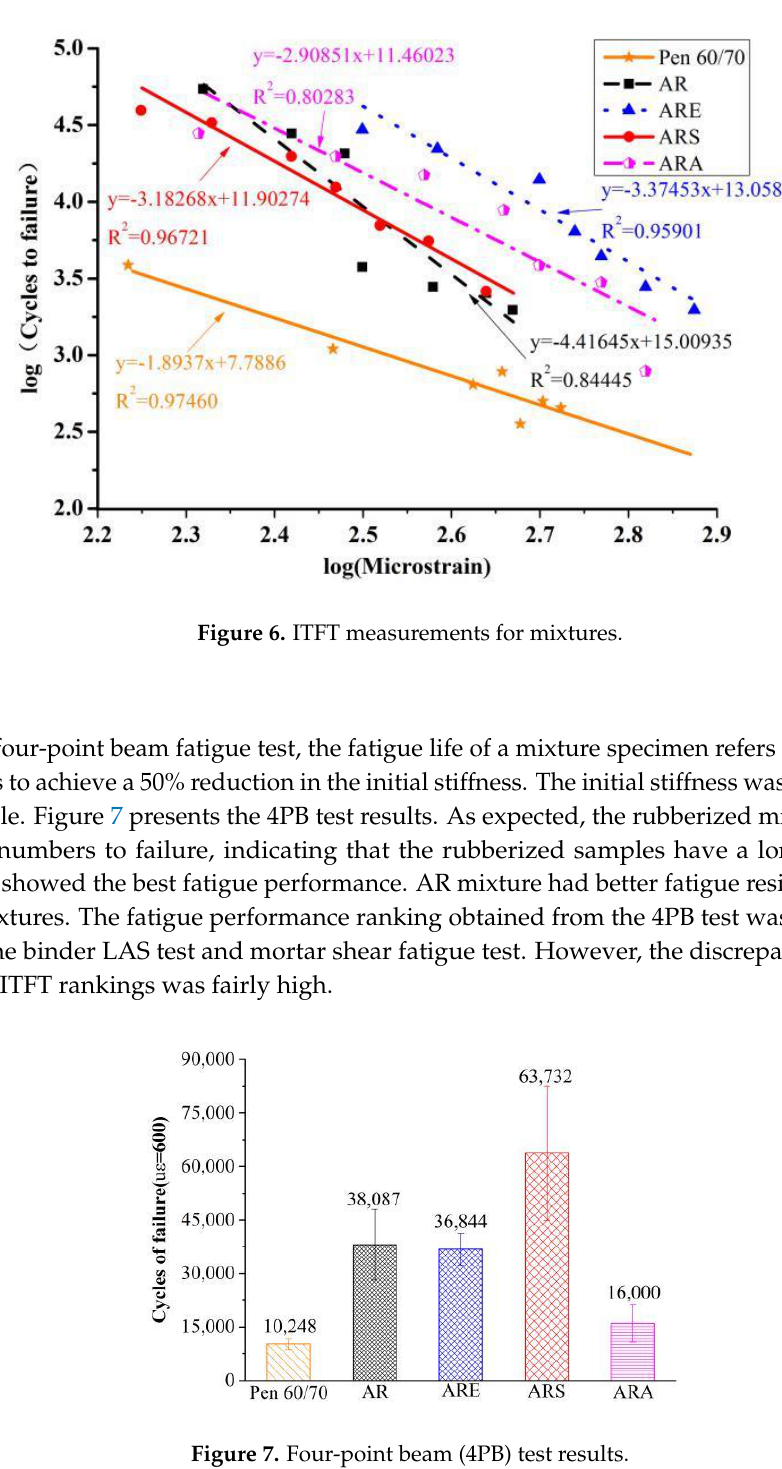
Figure 7. Four-point beam (4PB) test results.